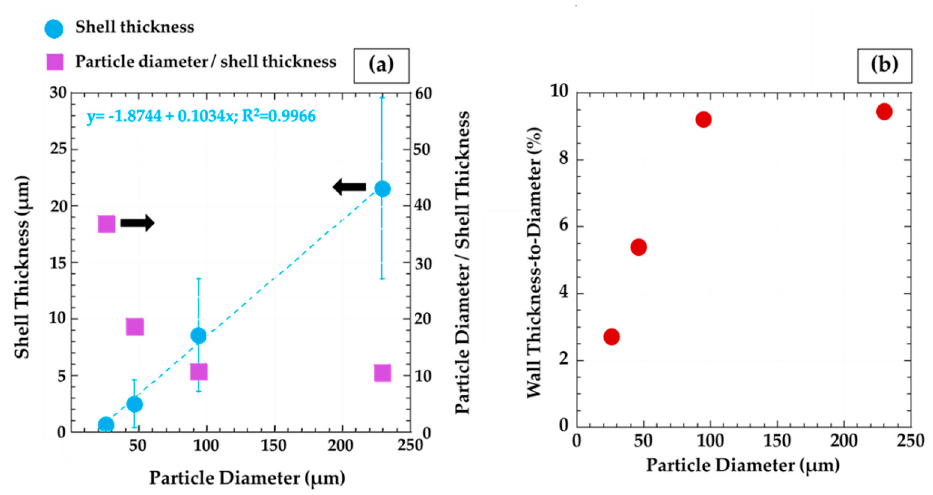
Figure 3. ( a ) Average shell thickness and particle diameter/shell thickness ratio plotted against particle diameter. ( b ) A plot showing a relation between percent wall thickness-to-diameter and particle diameter.